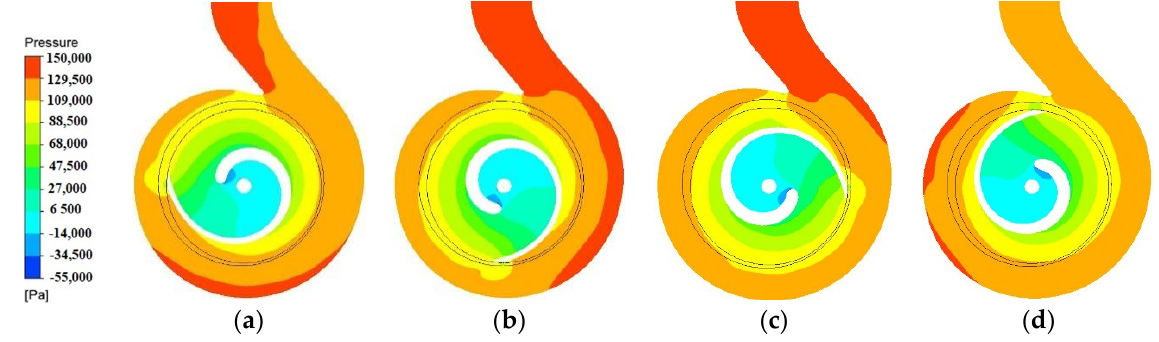
Figure 10. The Radial Force on the Impeller at 1.0 Q d . ( a ) non-eccentricity; ( b ) impeller eccentricity (2, −2).